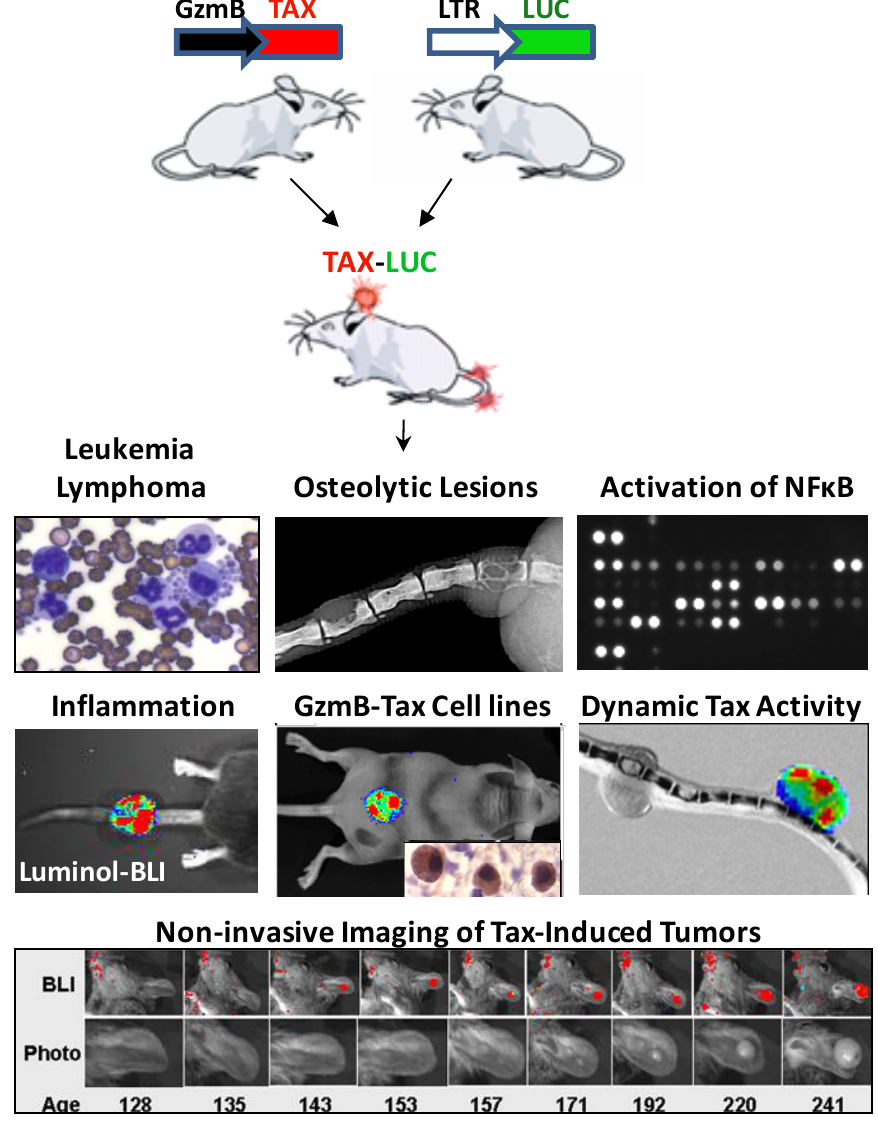
Figure 3. Tax transgenic mice model ATLL. Several Tax transgenic mouse models of ATLL have demonstrated the sufficiency of Tax as an independent oncogene. Second generation strains, such as the one depicted, have added capabilities, which enable non-invasive interrogation of various Tax activities using bioluminescence imaging